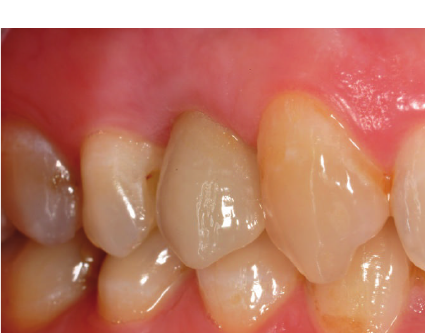
Figure 15: It was possible to digitally draw the custom titanium framework with an anatomic shape and a shoulder placed around the abutment head.